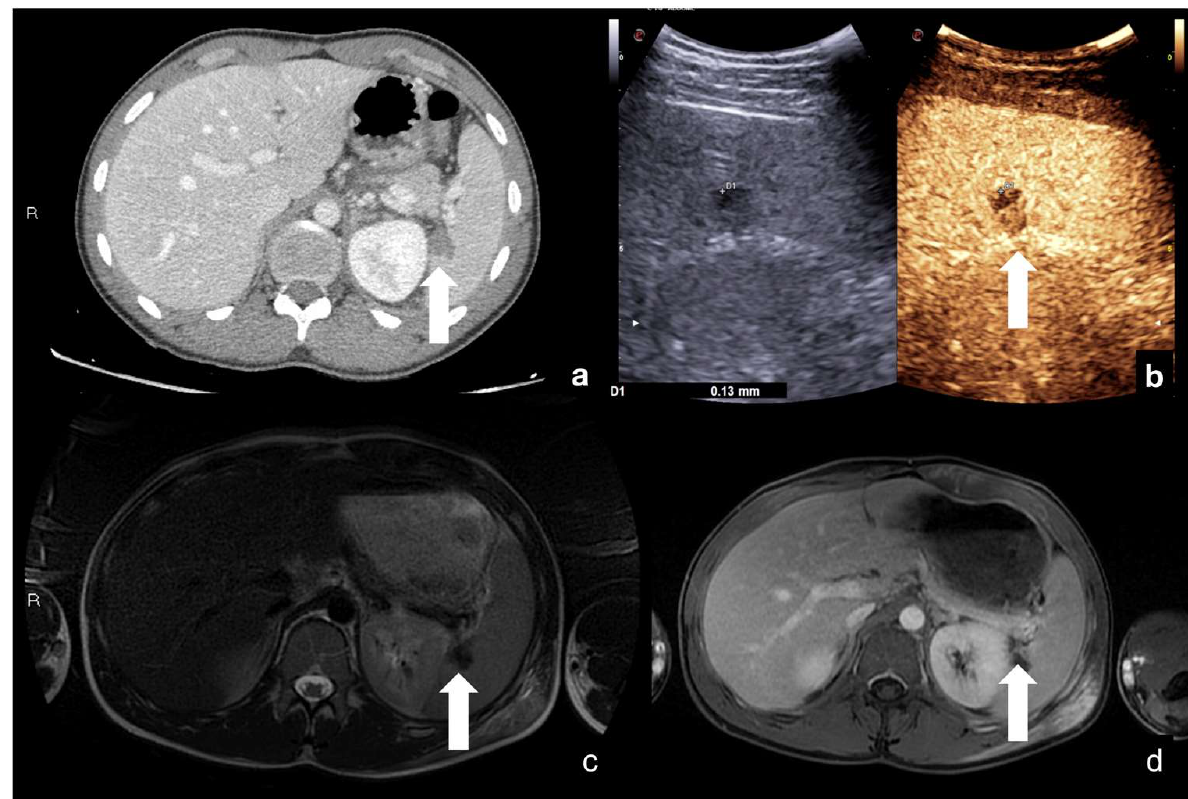
Figure 22. Multimodal evaluation of splenic laceration (white arrows) at portal phase CT scan ( a ), CEUS ( b ), fat-sat T2w ( c ), and post-contrast fat-sat T1w MRI ( d ), with good overlap of findings.